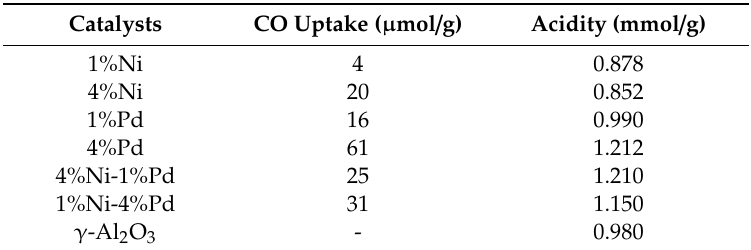
Table 2. CO chemisorption and NH 3 -TPD results of the Ni-Pd